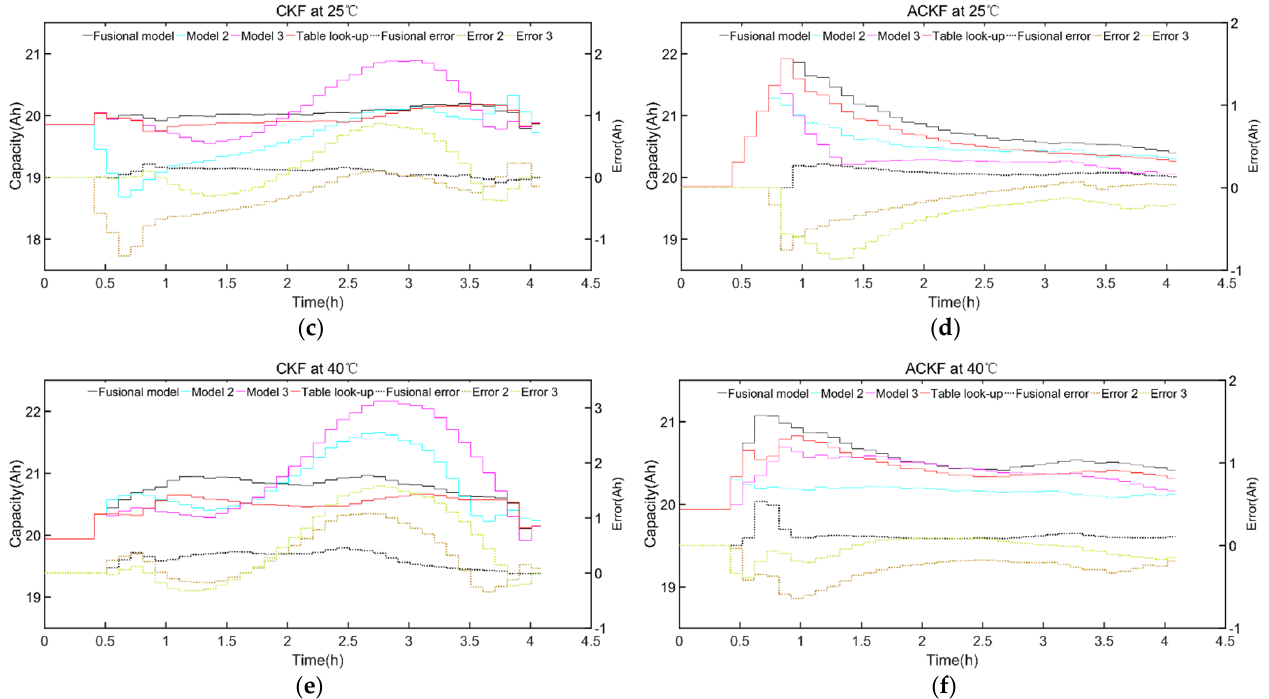
Figure 14. Capacity estimation results for LFP battery by using: ( a ) CKF at 10 °C. ( b ) ACKF at 10 °C. ( c ) CKF at 25 °C. ( d ) ACKF at 25 °C. ( e ) CKF at 40 °C. ( f ) ACKF at 40 °C. Table 10. RMSE of capacity estimation for LFP battery (Ah).